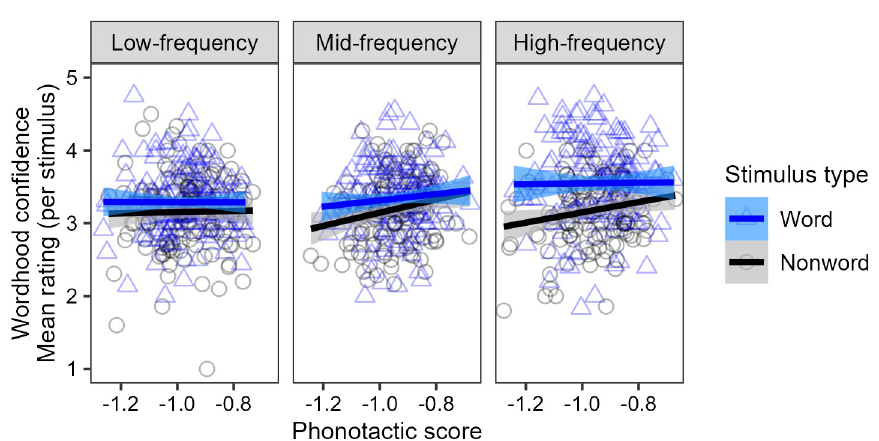
Fig 1. Summary of raw results from Experiment 1, showing participants’ mean wordhood confidence ratings for each stimulus per frequency bin, and their relation to phonotactic score. Points represent mean ratings for each real word (blue triangles) and nonword (black circles) within each bin, and straight lines show correlations with phonotactic scores. Across all bins, stimuli with higher phonotactic scores receive higher ratings, and real words receive higher ratings than nonwords, with this difference becoming particularly pronounced in the high-frequency